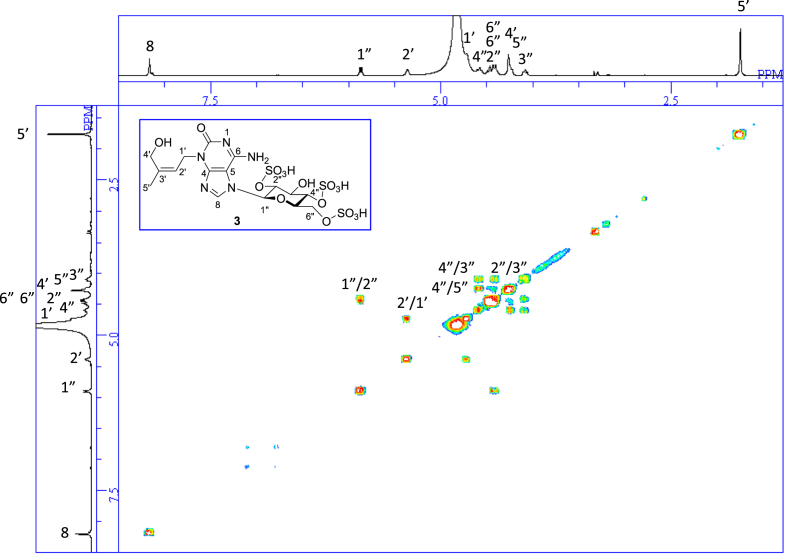
1H–1H COSY of 3.